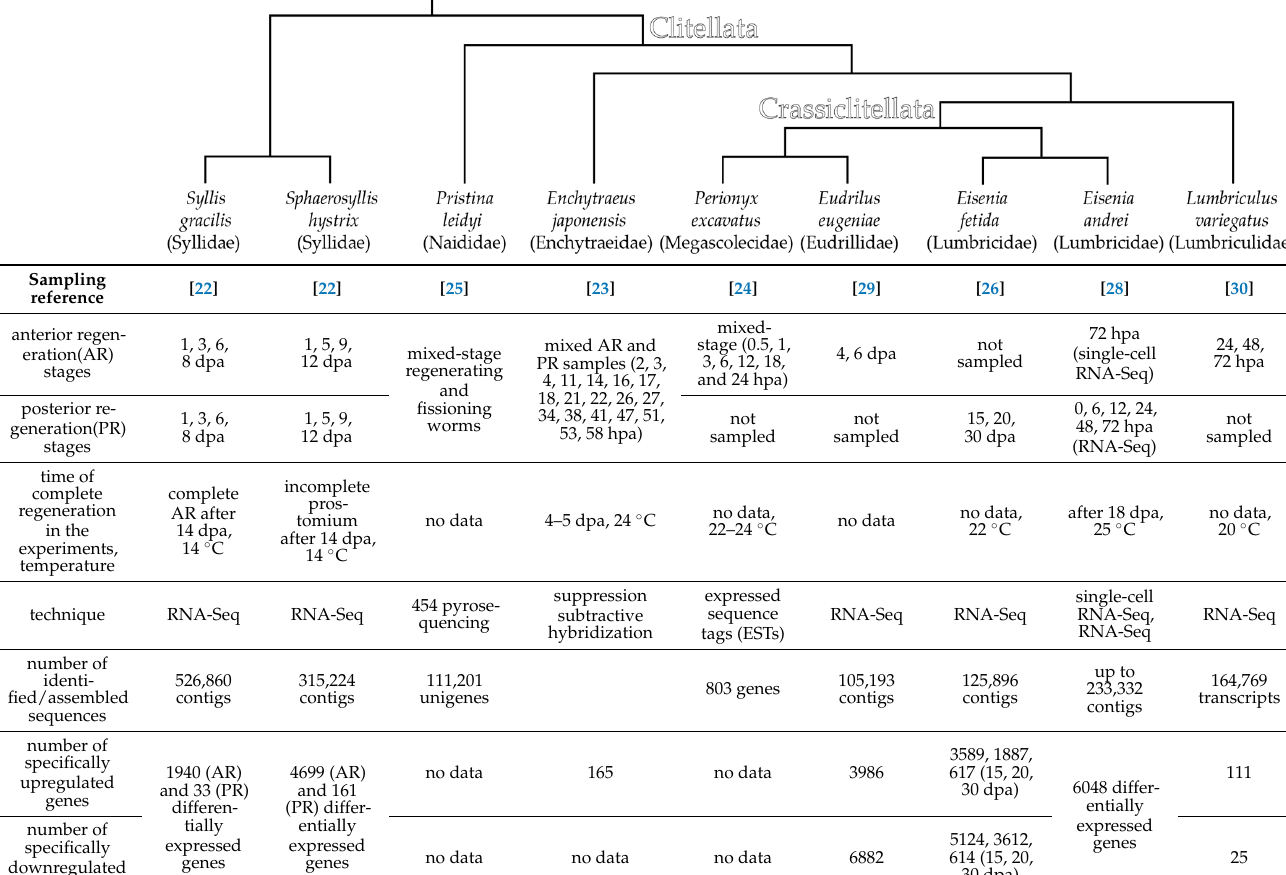
Table 1. An overview of the quantitative results of transcriptomic data on the annelid regenerates. dpa, days after amputation; hpa, hours after amputation.